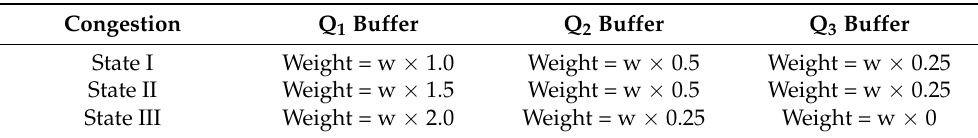
Table 2. CASPA algorithm weighting